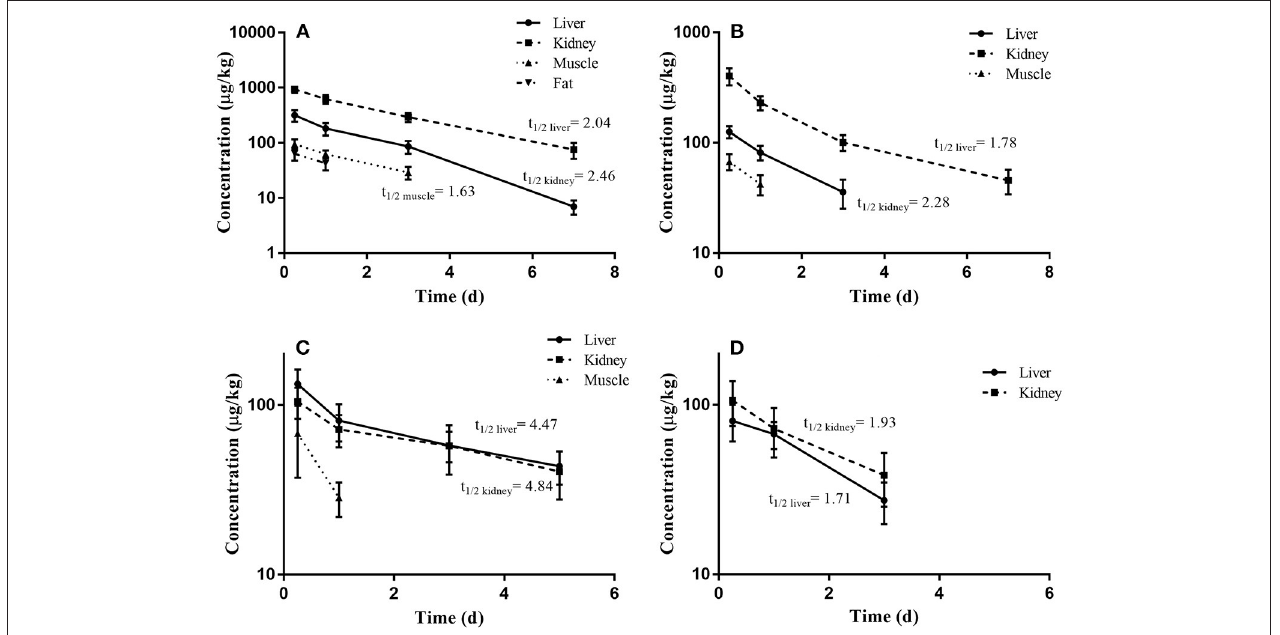
FIGURE 3 | The depletion plots of mean concentrations of O2 and O6 in the edible tissues of pigs and broilers slaughtered at different days following continuous feeding of olaquindox for 14 days (mean ± SD): (A) O2, (B) O6 in pig tissues; (C) O2, (D) O6 in broiler tissues.